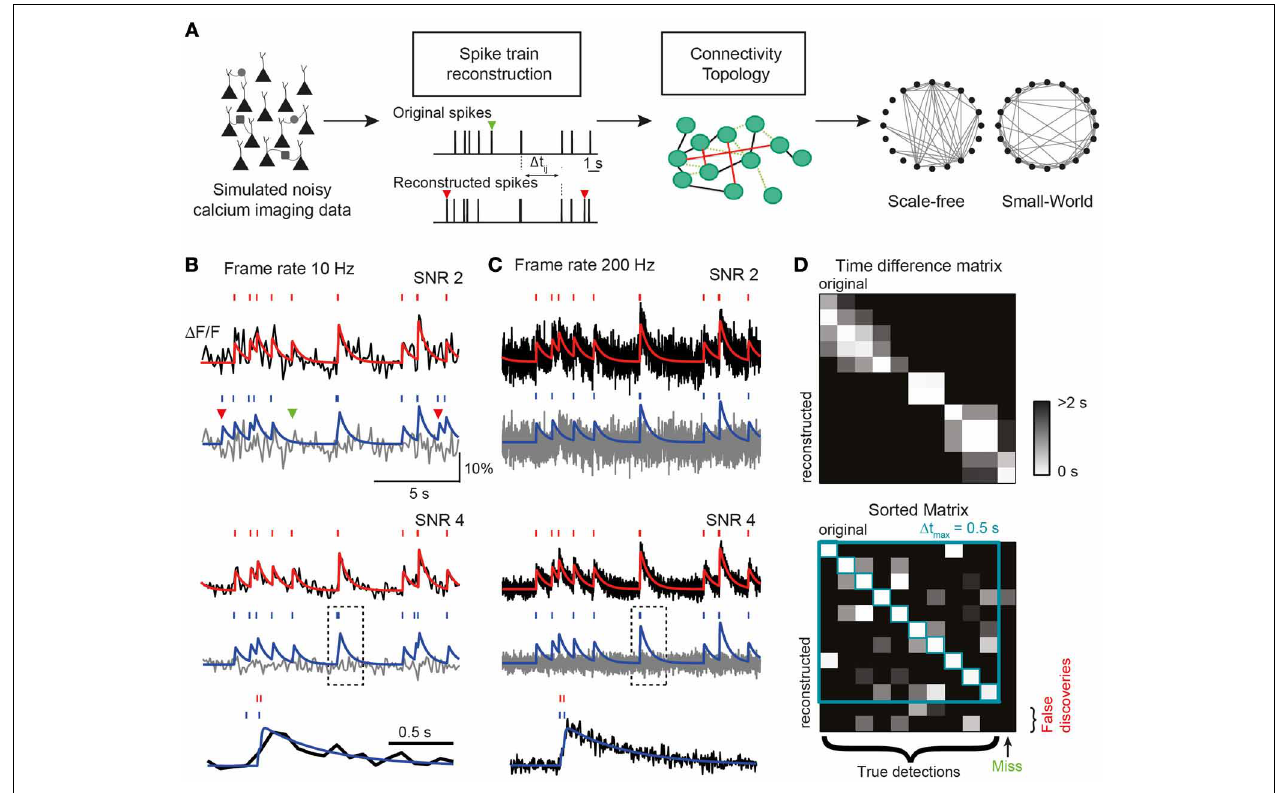
FIGURE 1 | (A) Conceptual link between neuronal network dynamics and structure in our study. Network dynamics measurable with calcium imaging techniques is simulated to investigate how well spike trains can be reconstructed for a broad value range of the most important experimental parameters. Reconstruction performance is condensed in three key parameters (TPR, true positive rate; FDR, false discovery rate; and σ (cid:2) t , temporal precision), which are used to analyze how well structural network properties such as topological characteristics (right) can be revealed depending on the attainable accuracy of spike train reconstruction. Missed (green) and falsely detected (red) spikes indicated by arrowheads. (B–D) Simulation of calcium traces from spike trains and subsequent reconstruction of firing pattern. (B) Top: simulated noise-free (red) and noisy (black) calcium traces for the example Poisson spike train ( SNR = 2; f = 10Hz). Bottom: reconstruction of spike train from simulated noisy calcium trace using the peeling algorithm. Reconstructed